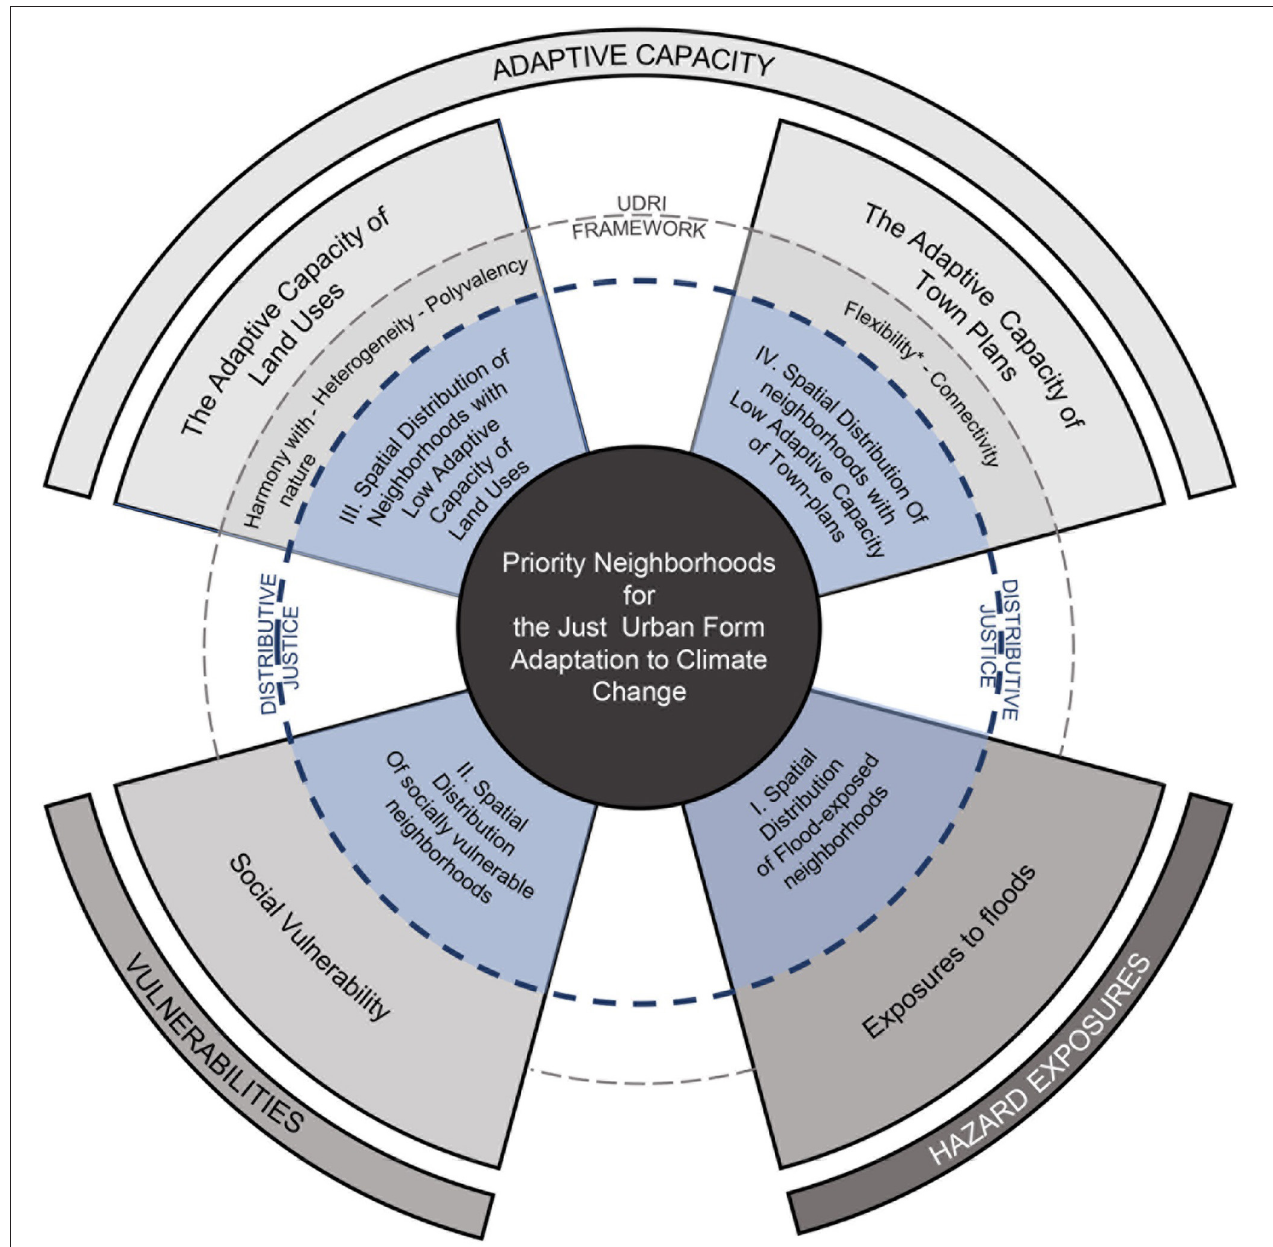
FIGURE 1 | The theoretical framework. *Flexibility is not included in the UDRI framework.